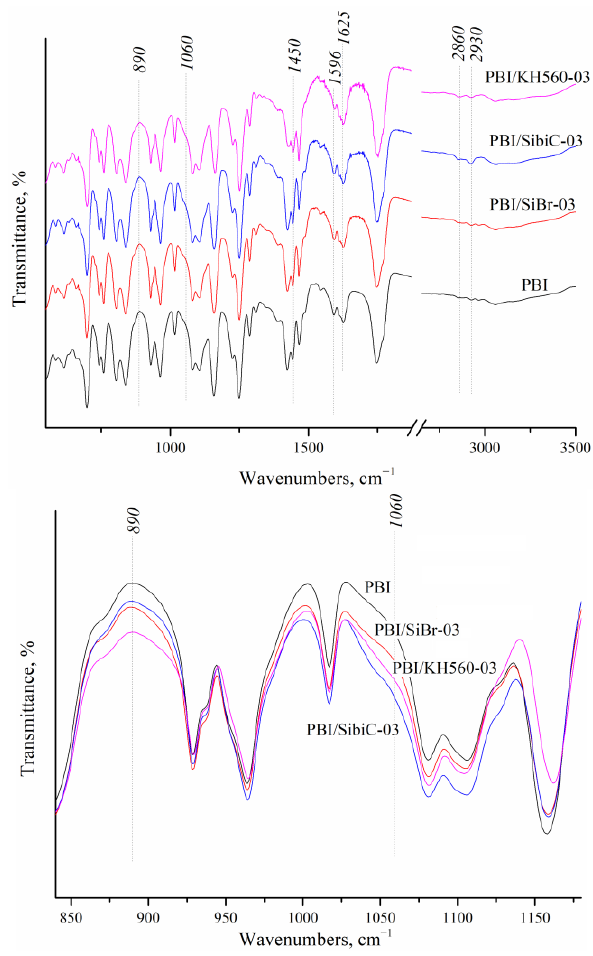
Figure 2. FTIR-spectra of crosslinked PBI membranes with different silanes.